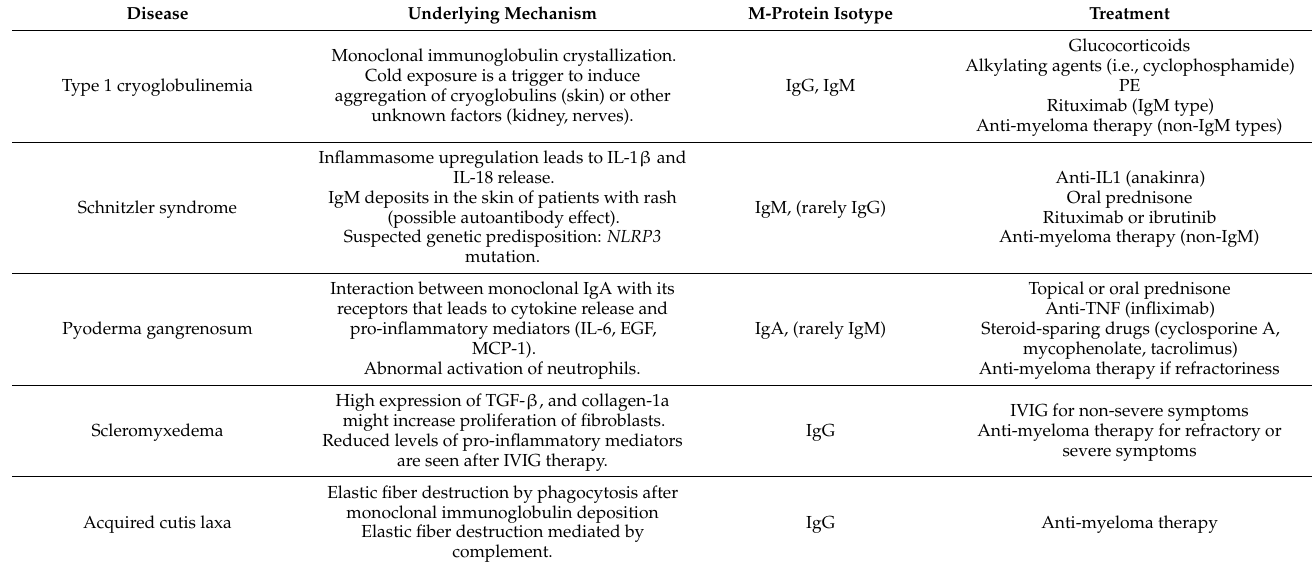
Table 2. Summary of treatment recommendations for skin conditions in MGCS. M-protein, monoclonal protein; Anti-IL1, anti-interleukin 1; anti-TNF, anti-tumoral necrosis factor; IVIG, intravenous immunoglobulins; anti-myeloma therapy: proteasome inhibitors, immunomodulatory drugs, +/– high-dose melphalan with autologous stem cell transplant.